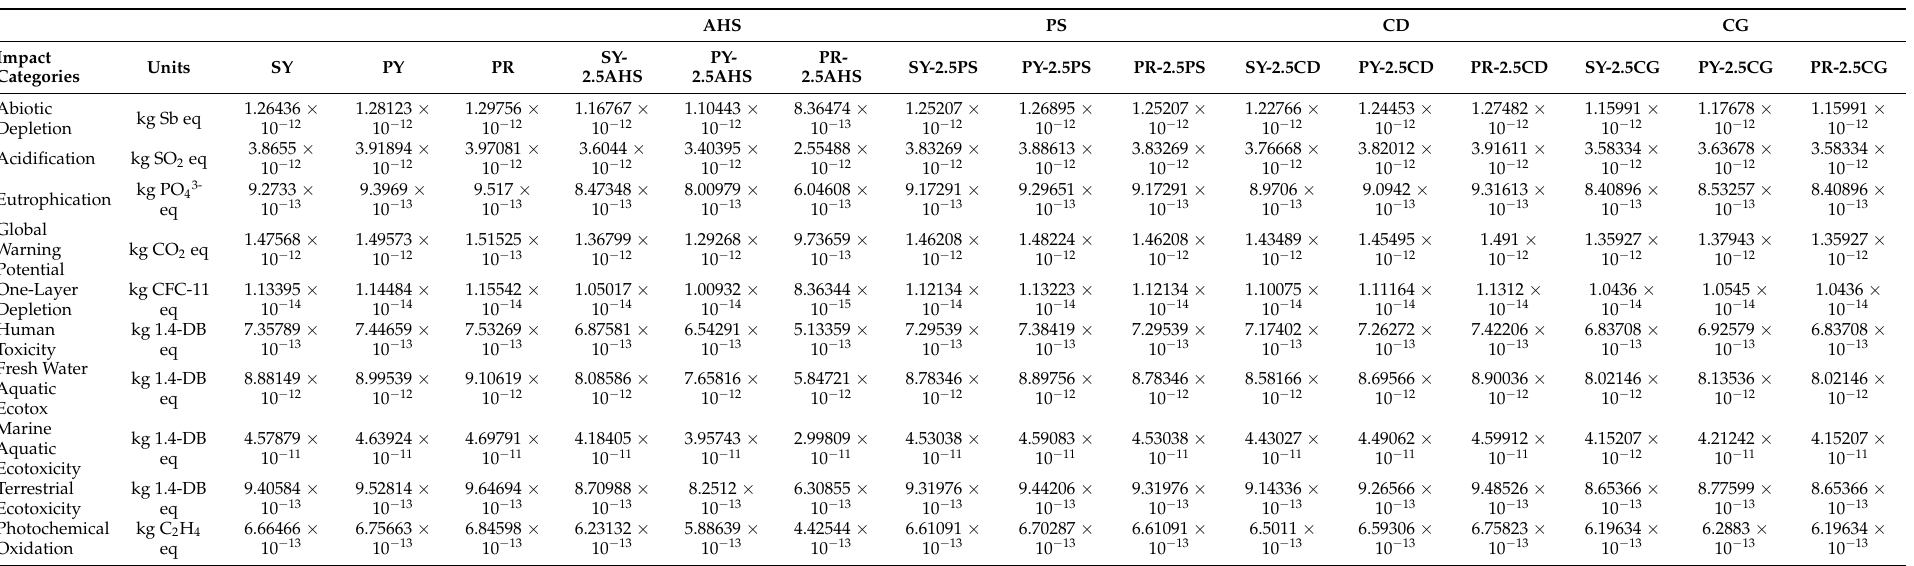
Table 5. Normalized impacts associated with 1 kg of lightweight aggregates incorporating 0 and 2.5 wt % of AHS, PS, CD and CG,